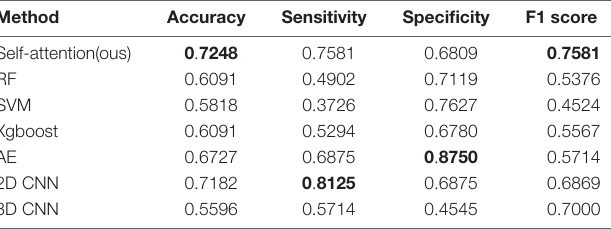
TABLE 1 | Comparison of the classification performances between our method and other